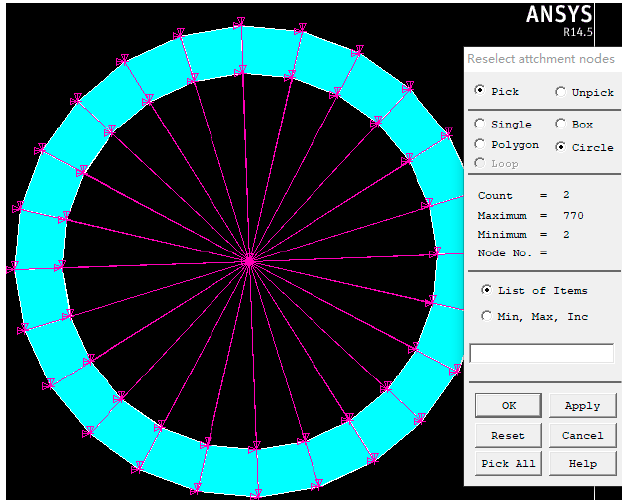
Figure 10. The preprocessing model (.mnf) obtained from ANSYS. For the multisection continuum arms system, the gravity direction is specified as the negative direction of the Y ‐ axis. The material property of the rigid part is defined as structural steel. The command trajectory x d ( t ) of the end of the multisection